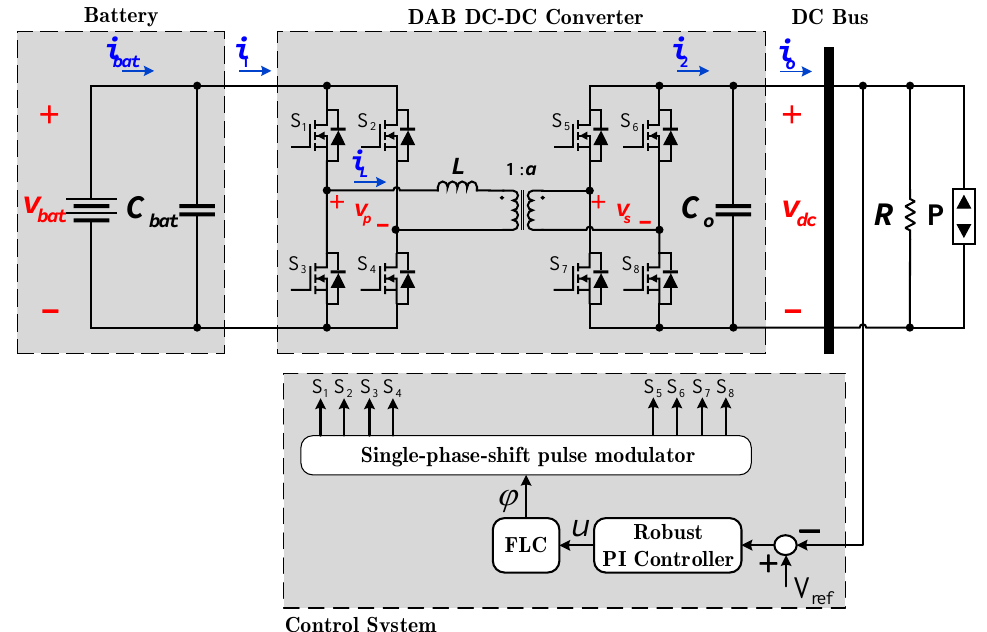
Figure 8. Proposed control scheme for DAB converter in battery discharging mode under single-phase- shift (SPS)